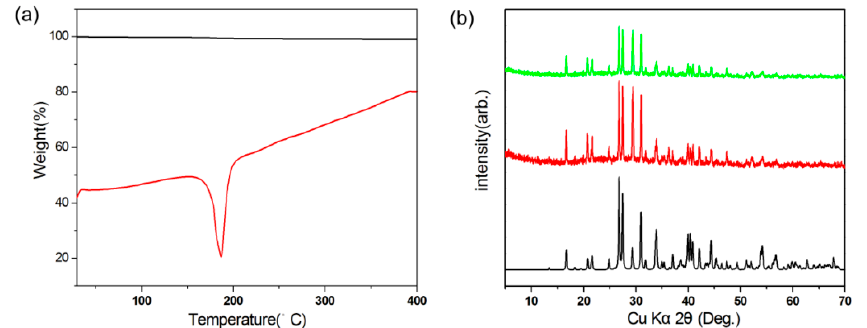
Figure 2. ( a ) Thermogravimetric/differential thermal analysis (TG/DTA) diagrams and ( b ) experimental and calculated powder X-ray diffraction (PXRD) patterns for Rb 2 Na(NO 3 ) 3 . Only one endothermic peak in the DTA curve and the identical PXRD patterns before and after melting suggest that Rb 2 Na(NO 3 ) 3 does not change the phase all the time and melts congruently.